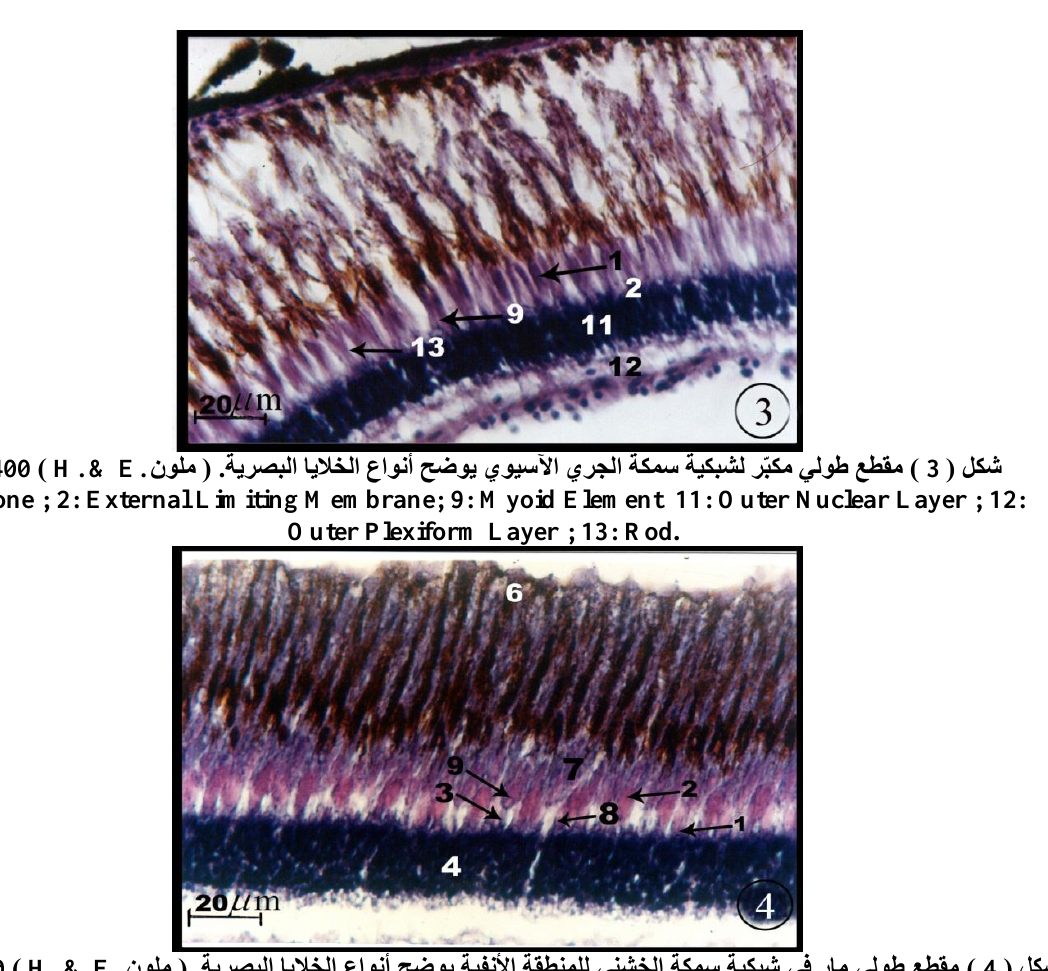
3 : External Limiting Membrane ; 4: Ganglion Cells Layer ; 6: inner Limiting membrane ; 7: Inner Nuclear Layer ; 8: Inner Plexiform Layer ; 10: Outer Nuclear Layer; 11: Outer Plexiform Layer ; 12: Pigment Epithelium ; 14: Visual Cells.